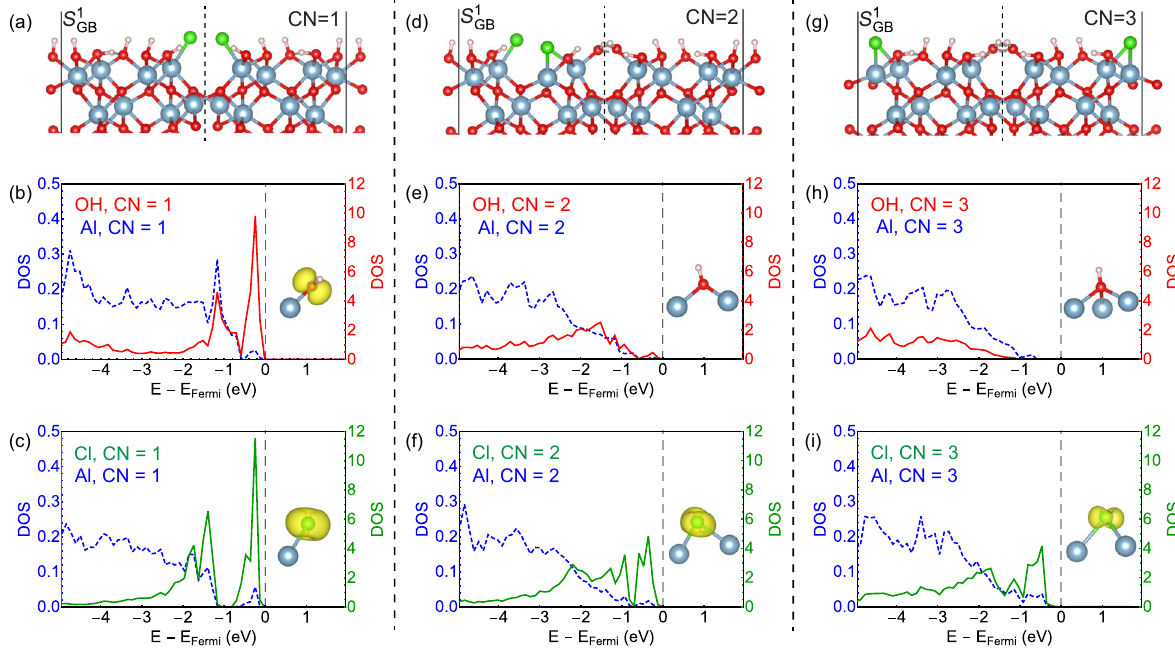
Fig. 9 Surface electronic structures for 2 Cl OH at different sites. a 2 Cl OH adsorbed at the OH sites with CN = 1. For clarity, only atoms within two oxygen layers from the surface are shown. b PDOS at the CN = 1 sites for the saturated surface before the Cl OH adsorption. The solid red line represents the PDOS of the 2 OH. The dashed blue line represents the PDOS of the 2 Al that are bonded to the 2 OH. c PDOS at the CN = 1 sites for Cl OH . The solid green line represents the 2 Cl. The dashed blue line represents the PDOS of the Al atoms that is bonded to the Cl. d – f Surface con fi guration ( d ), the PDOS of Al/OH before the Cl OH adsorption ( e ), and the PDOS of Al/Cl after the Cl OH adsorption ( f ) at the sites of CN = 2. g – i Surface con fi guration ( g ), the PDOS of Al/OH before the Cl OH adsorption ( h ), and the PDOS of Al/Cl after the Cl OH adsorption ( i ) at the sites of CN = 3. For all PDOS plots, inset fi gures show the partial charge density of the anion species integrated over the PDOS peak just below the Fermi level (E − E Fermi ∈ [ − 1, 0]